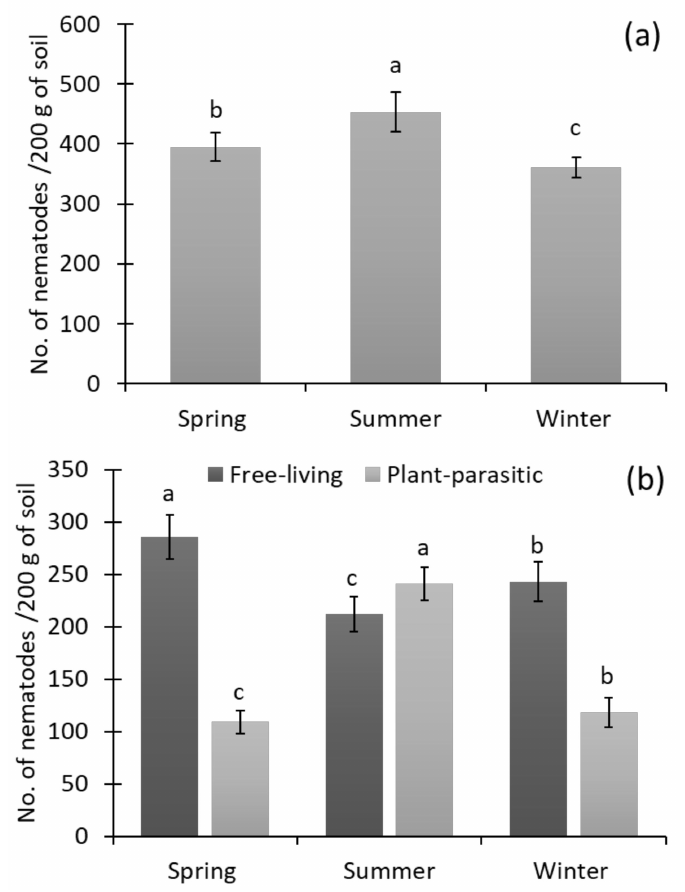
Figure 3. The soil nematode abundance ( a ), and contribution of free-living and plant-parasitic nematode abundance ( b ) in the rice fields at the three different seasons of the year. Bars represent the mean of 72 soil samples ( ± SD) and different letters on the bars show the significance at p ≤ 0.05 among the different